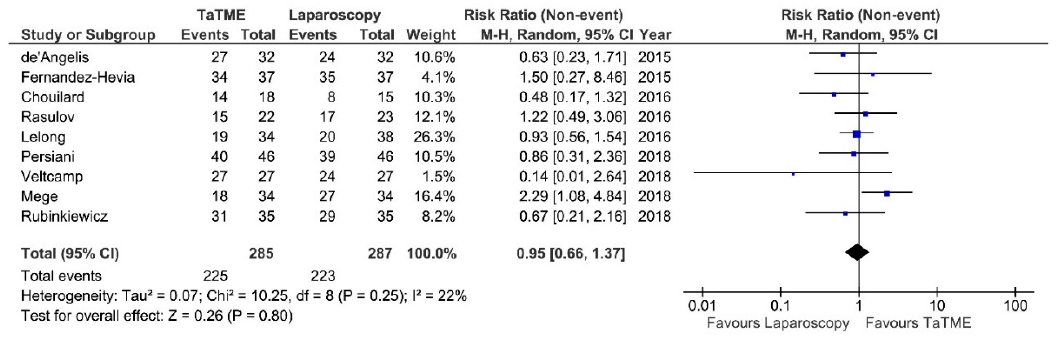
Figure 7. Completeness of mesorectal excision. CI—Confidence Interval; df—degrees of freedom, M-H—Mantel-Haenszel test. WMD and RR are presented on the graphs as squares, and overall WMD and RR is presented as diamond.